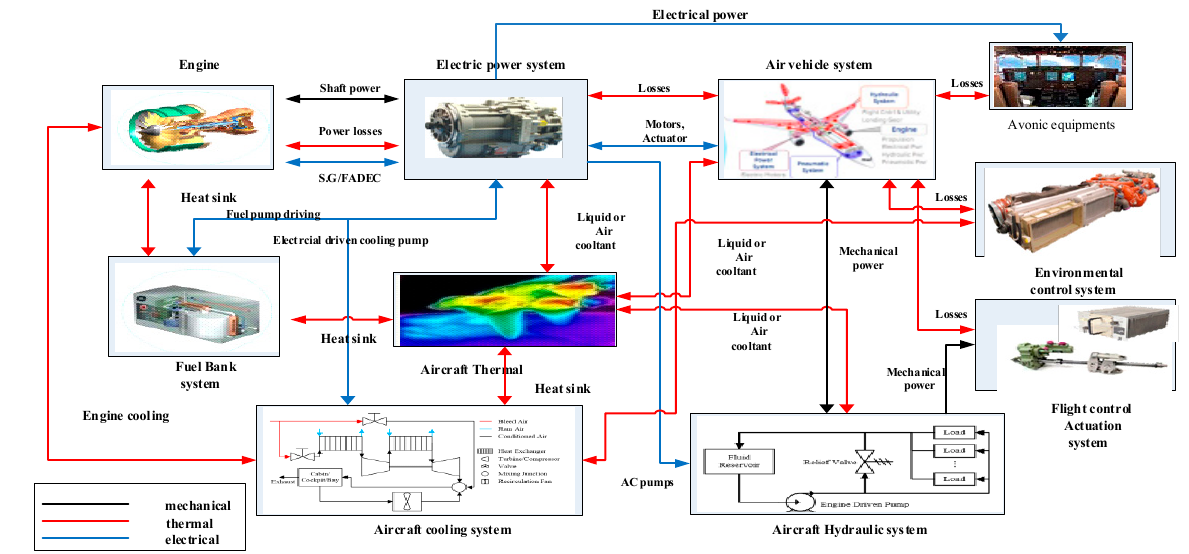
Figure 10. The multi-energy domain interactions in an aircraft power system.